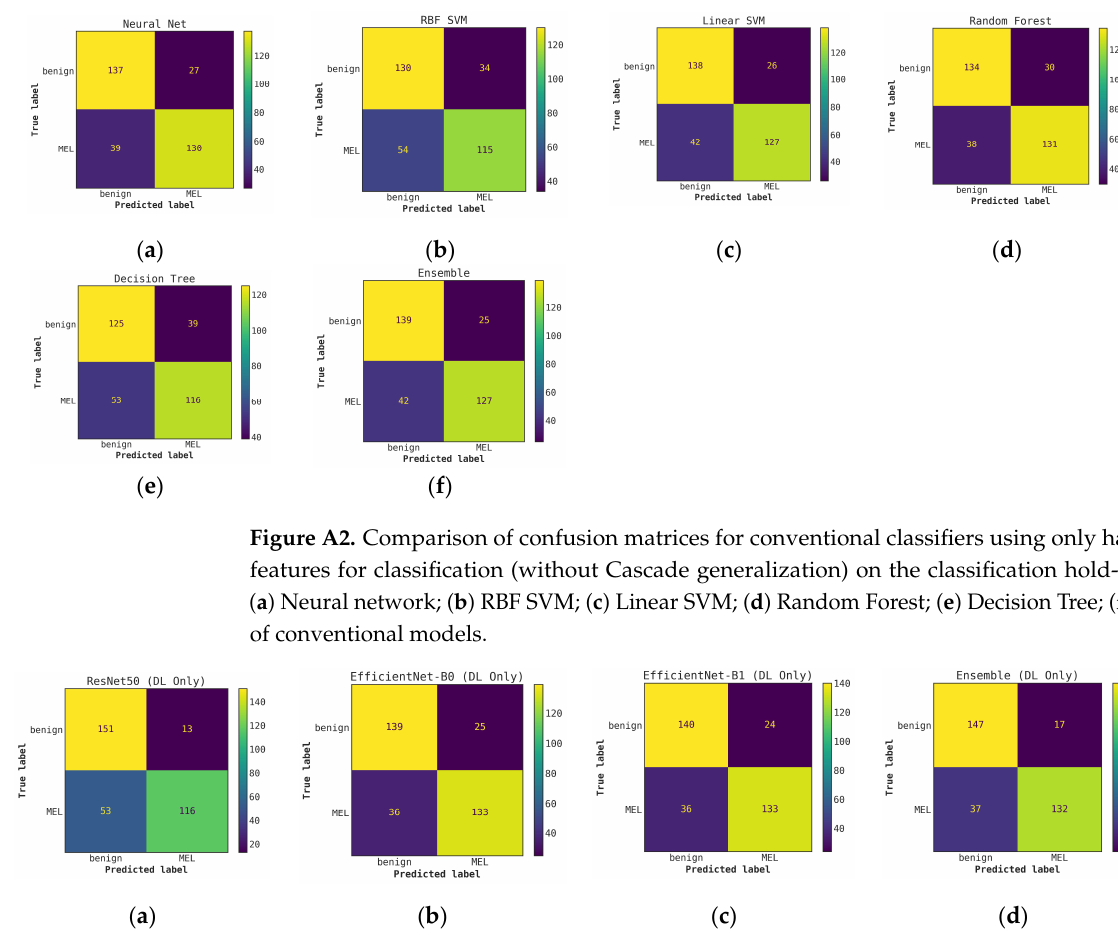
Figure A1. Comparison of ROC curves for conventional classifiers, DL classifiers, and their respec- tive ensembles obtained by averaging the output probabilities. ( a ) ROC curves for conventional classifiers applied directly to hand-crafted features, without cascade generalization; ( b ) ROC curves for the deep learning (DL) models only and their ensemble. The area under the curve (AUC) and the AUC for a false-positive rate higher than 0.4 are both presented for comparison. All values are rounded to three significant digits.